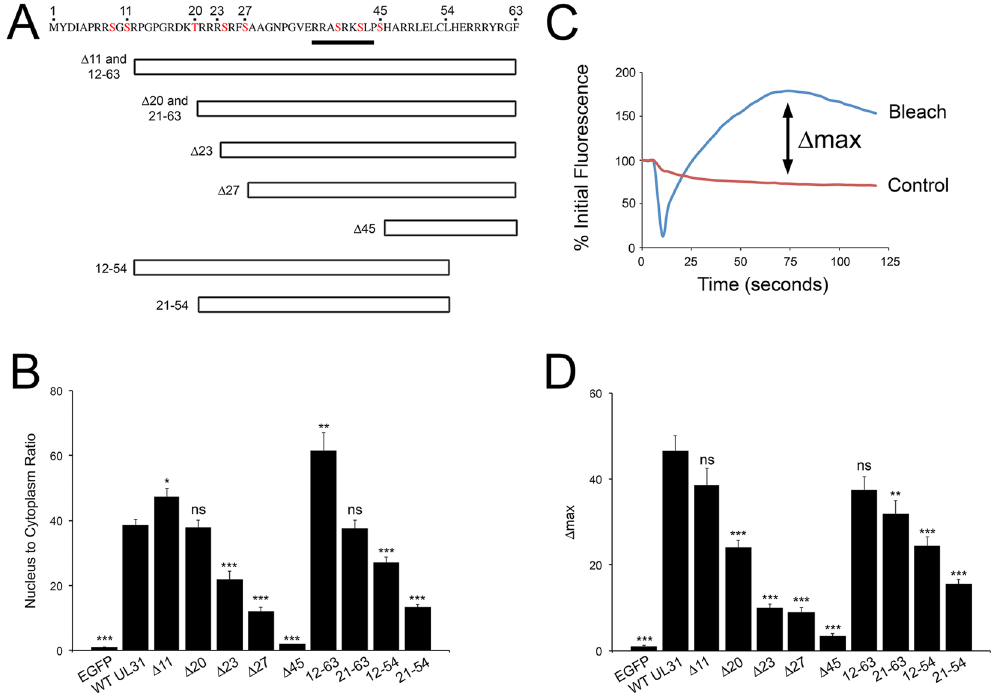
Figure 5. Identification of regions of UL31 required for nuclear localization and recruitment to sites of laser microirradiation. ( A ) Sequence of the N-terminal 63 amino acids of HSV-2 UL31. Serine (S) and threonine (T) residues highlighted in red are predicted to be modified by Us3 16 . Underlined residues are 75% similar to a canonical poly-ADP-ribose binding motif. Various C-terminal and N-terminal truncations of UL31 analyzed in these experiments are shown. ( B ) Images of live HeLa cells transfected with plasmids expressing the indicated EGFP tagged protein were captured using an Olympus FV1000 laser-scanning confocal microscope over the course of two independent experiments with n ≥ 7 cells/experiment. The relative fluorescence intensity in the nucleus and the cytoplasm was determined using Fluoview software version 1.7.3.0 and the nucleus:cytoplasm ratio calculated. Error bars represent standard error of the mean. Using an unpaired t test the nucleus to cytoplasm ratio of WT UL31 was compared to the other proteins (ns = not significant, * p < 0.05, ** p < 0.01, *** p < 0.001). ( C ) We define Δ max as the largest positive difference between the fluorescence intensity of the laser microirradiated region (Bleach) and a control region (Control) over the course of the experiment. ( D ) The Δ max of the various UL31 constructs. HeLa cells transfected with plasmids expressing the indicated protein were microirradiated as described above and Δ max was calculated for each construct. n ≥ 7 cells/experiment in two independent experiments for each construct analyzed. Error bars represent standard error of the mean. Using an unpaired t test the Δ max of WT UL31 was compared to the other proteins (ns = not significant, * p < 0.05, ** p < 0.01, *** p <